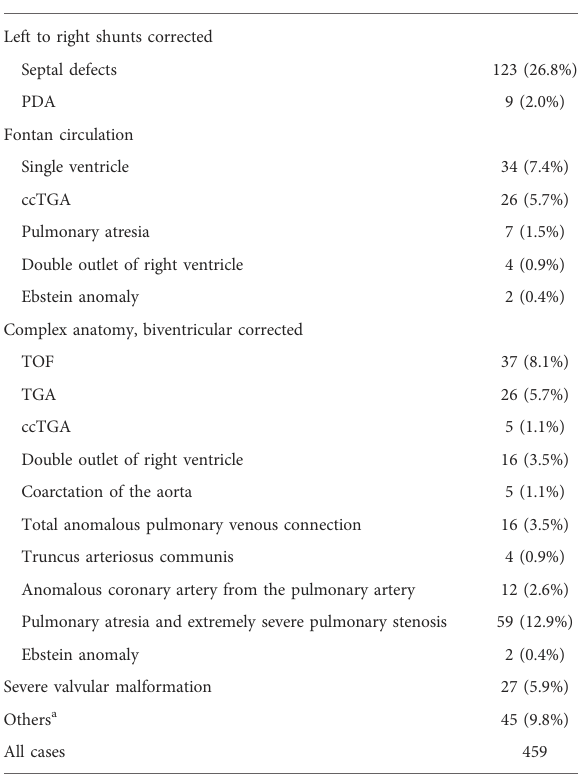
TABLE 1 Primary diagnostic categories of the study population. Classi fi cation of congenital heart